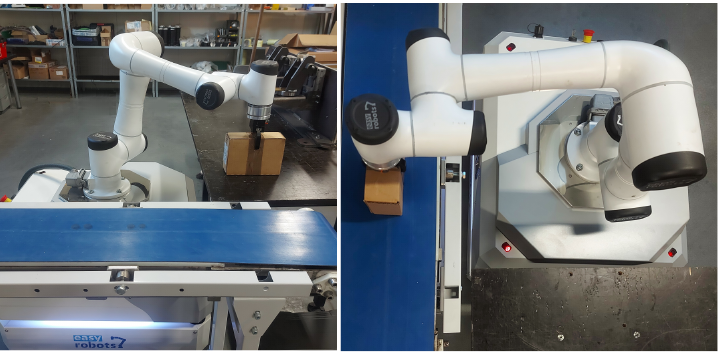
Figure 8. Six-degrees-of-freedom articulated ES5 robot and autonomous mobile